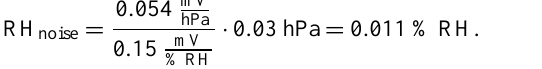
Figure 7. Relation between relative humidity and output voltage for four sensors. The sensitivity of the four sensors is between 0.24mV/%RH and 0.26mV/%RH. The fact that all four curves are almost parallel is interesting for a one-point calibration (see Sect.